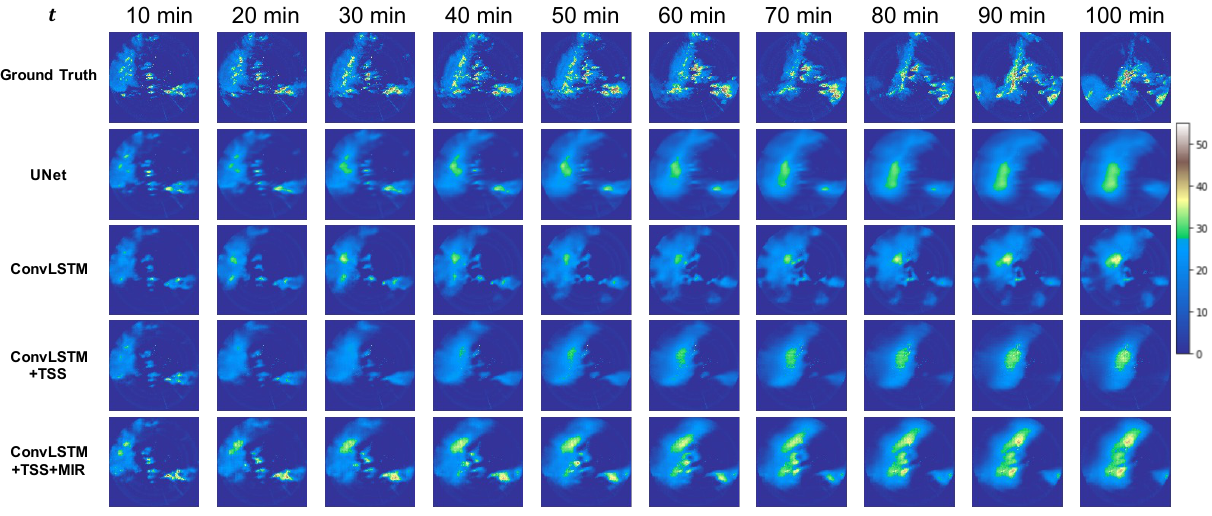
Figure 5. Radar reflectivity predictions of different